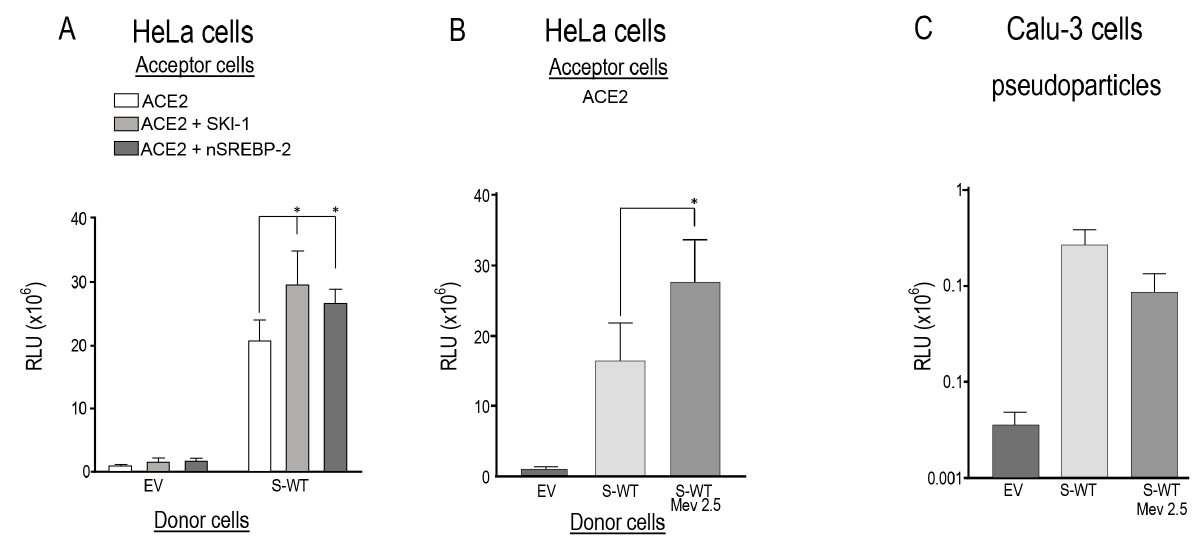
Figure 3. SKI-1 and nSREBP-2 enhance cell-to-cell fusion. ( A ) HeLa cells were transiently transfected with an empty vector (EV) or one encoding WT-spike (S). Acceptor TZM-bl cells were transfected with a vector expressing ACE2 alone or with vector expressing either SKI-1 or nSREBP-2. After 48 h, donor and acceptor cells were co-cultured for 18 h. ( B ) Donor cells were transfected with vectors expressing either no protein (empty vector, EV) or WT-spike (S) were co-cultured for 18 h with acceptor TZMbl HeLa cells expressing ACE2 receptor. Prior to co-culture, the cells were treated with 2.5 mM mevalonate. Relative luminescence units (RLU) were normalized to the EV value arbitrarily set to 1. Data are presented as mean values ± SD (n = 3 independent experiments). ( C ) Calu-3 cells were transduced with nanoluciferase-expressing HIV particles pseudotyped with empty vector (EV) or SARS-CoV-2 wild-type spike (WT), in absence or presence of 2.5 mM of Mevalonate (Mev). Pseudoparticle entry was expressed as relative luminescence units (RLU). Representative blots of at least three independent experiments are shown. p values (*, p < 0.05) were evaluated by a Student’s t